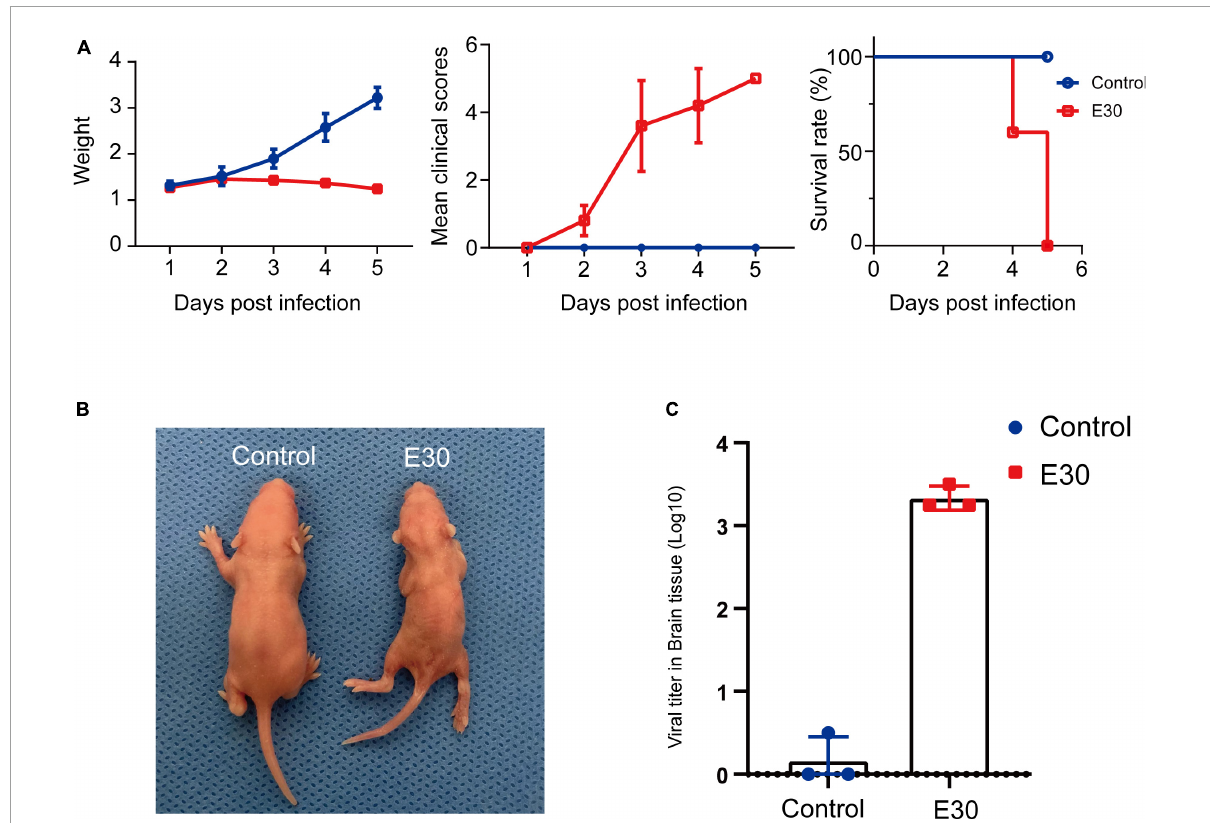
FIGURE3 E30 infects ICR suckling mice. (A) Body weight, clinical score, and survival in ICR suckling mice infected with E30. (B) Clinical symptoms of E30 infection in ICR suckling mice. (C) Virus tissues in brain tissues 5 days after